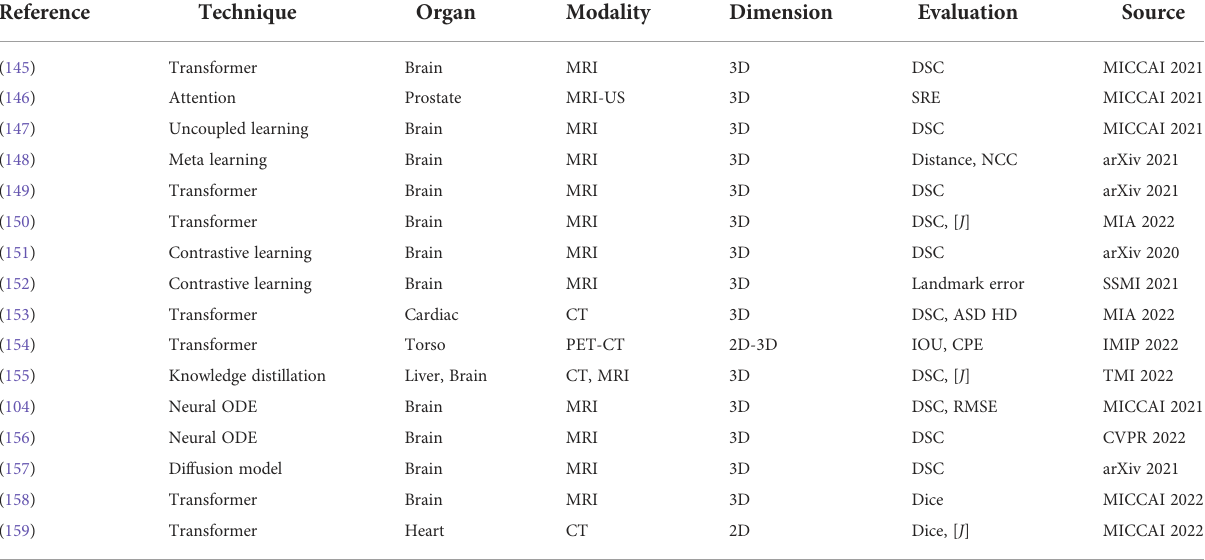
TABLE 6 Image registration with latest